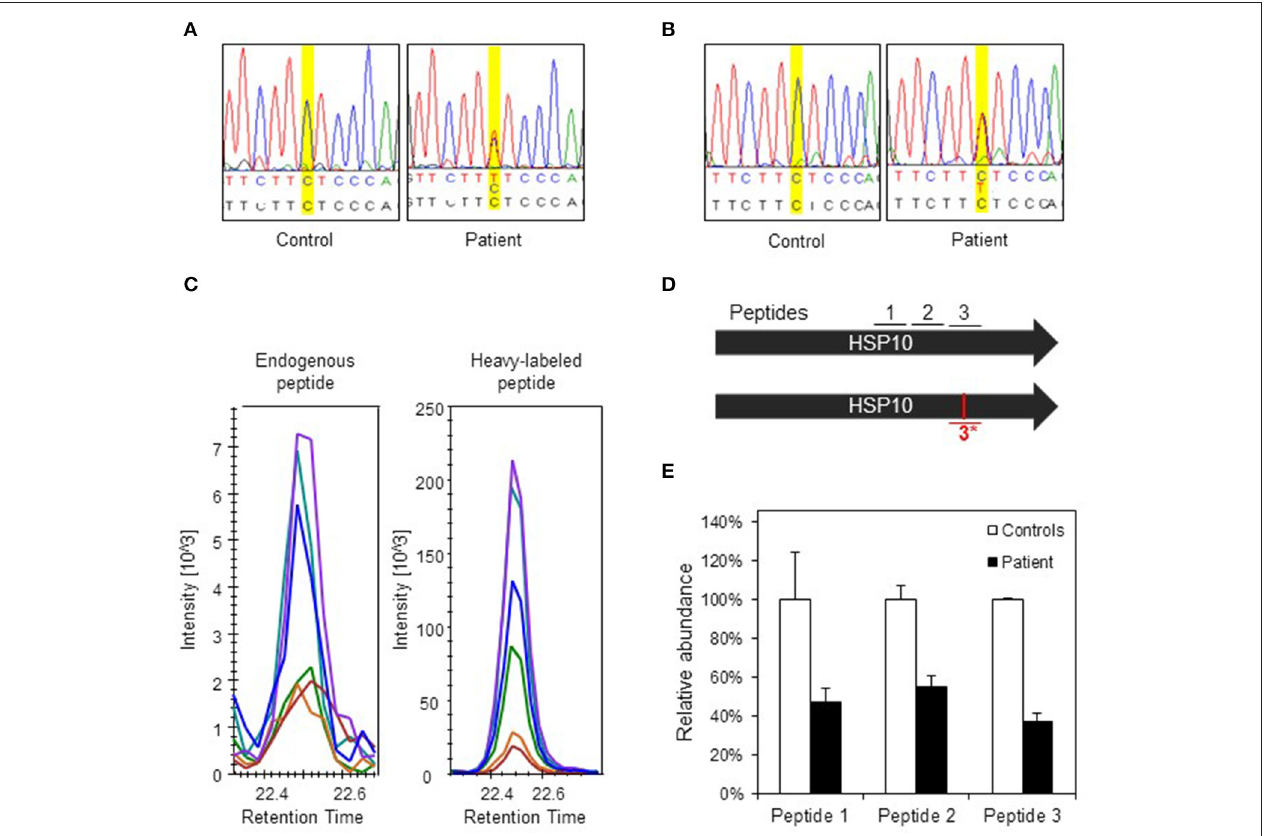
FIGURE 3 | Analysis of DNA, RNA, and protein in patient fibroblasts. (A) Confirmation of c.217 C > T mutation in patient fibroblasts. A fragment spanning the mutation site was amplified by PCR and analyzed by Sanger sequencing. Yellow highlighting indicates position c.217 and bases are indicated below: top line depicts bases found by sequencing, lower line shows reference sequence. (B) Sequencing of transcripts. Total RNA was isolated from control and patient fibroblast and used for cDNA synthesis followed by PCR amplification of a fragment comprising the mutation site. PCR fragments were analyzed by Sanger sequencing. (C) Detection of the mutant peptide in patient fibroblasts by SRM-MS. The fragmentation patterns for the analyzed peptide fragments for the mutant peptide (#3*) detected in fibroblasts from the patient (left panel) and the heavy-labeled peptide that was spiked into the sample (right panel) are shown. The graphs show the peaks for the different fragment ions in corresponding colors. (D) Peptides used for SRM analysis. Bars show the two HSP10 alleles of the patient with position of the peptides and the mutation site. Peptides #1 and #2 are common to wild type and p.Leu73Phe HSP10 and the peptides spanning the mutation site (#3 wild type and #3*, mutant) are depicted. (E) Quantification of HSP10 in patient and control fibroblasts. The two peptides common to both wild type and p.Leu73Phe HSP10 (#1 and #2) and the peptide with wild type sequence spanning the mutation site (#3) were quantitated by SRM analysis as described in Materials and Methods. The mean of the quantitated amounts of the three peptides measured in three different control fibroblast cultures were set to 100% and the mean amounts measured in three patient cell cultures grown in parallel were expressed as percentage of these. Error bars denote standard deviation of the